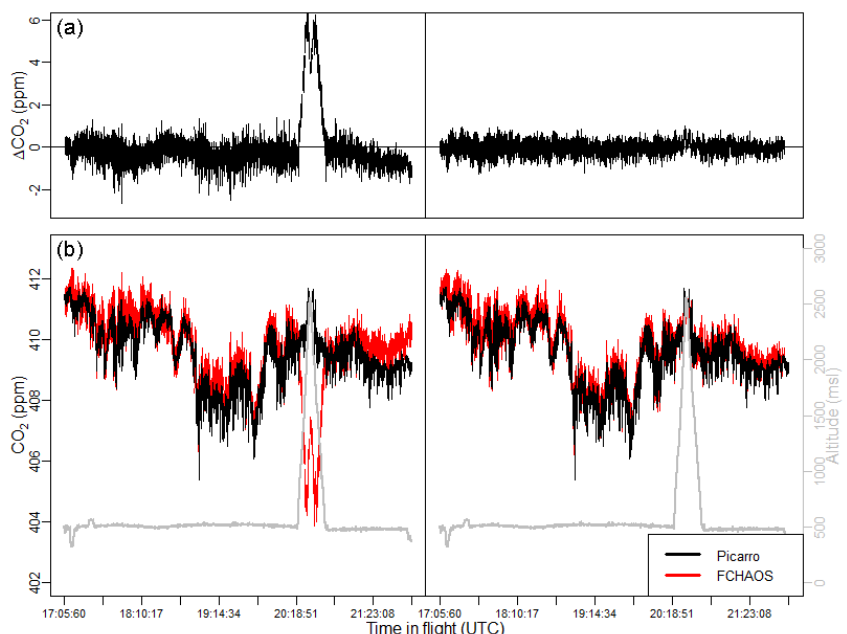
Figure 8. Panel (b) shows Picarro G2301-f and uncalibrated FCHAOS CO 2 time series on left, Picarro G2301-f and calibrated FCHAOS CO 2 on right. Panel (a) shows the difference between the two instruments with and without FCHAOS calibration. The calibration procedure corrects for any artifacts in the FCHAOS data correlated with aircraft